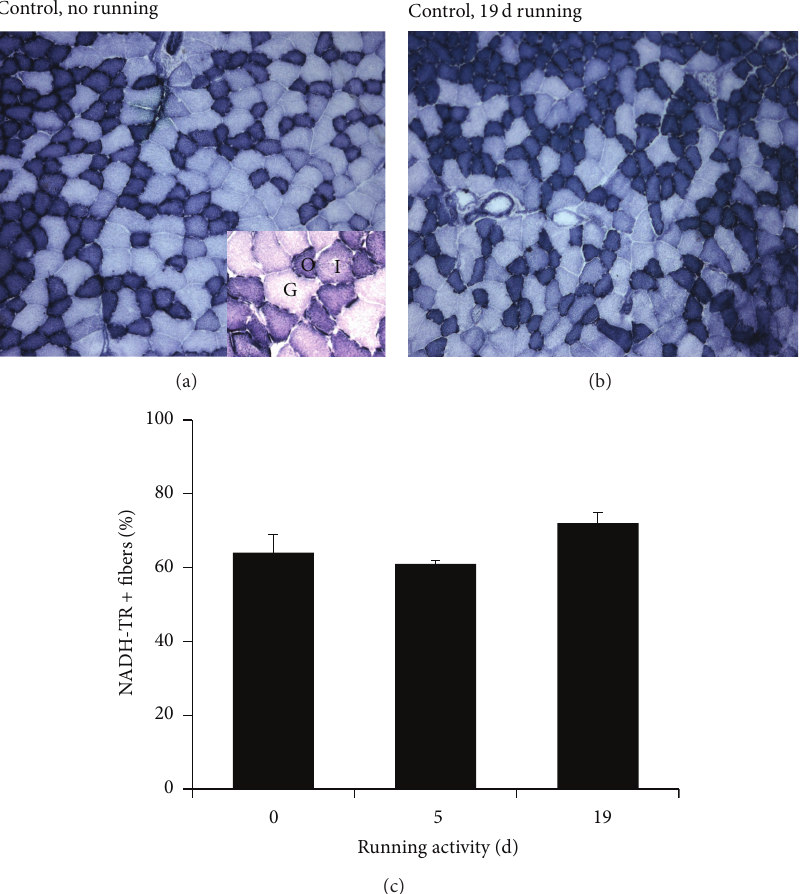
Figure 3: Muscle metabolic adaptations to wheel running in BALB/c AnNCrl mice. Histochemistry for NADH transferase activity highlights oxidative (O), intermediate (I), and glycolytic (G) fibers; that is, muscle fibers that are rich (O or I) and poor in mitochondrial content, respectively. The inset at higher magnification allows to differentiate among the three types of fibers. O + I fibers were collectively considered as rich in NADH transferase ( NADH-TR + fibers ). Representative photomicrographs of the TA of (a) control, nonexercised mouse and (b) a mouse following nineteen days of exercise. The percentage of NADH-TR+ fibers was quantified in replicate, after no ( 0 ), five (5), or nineteen ( 19 ) days of wheel